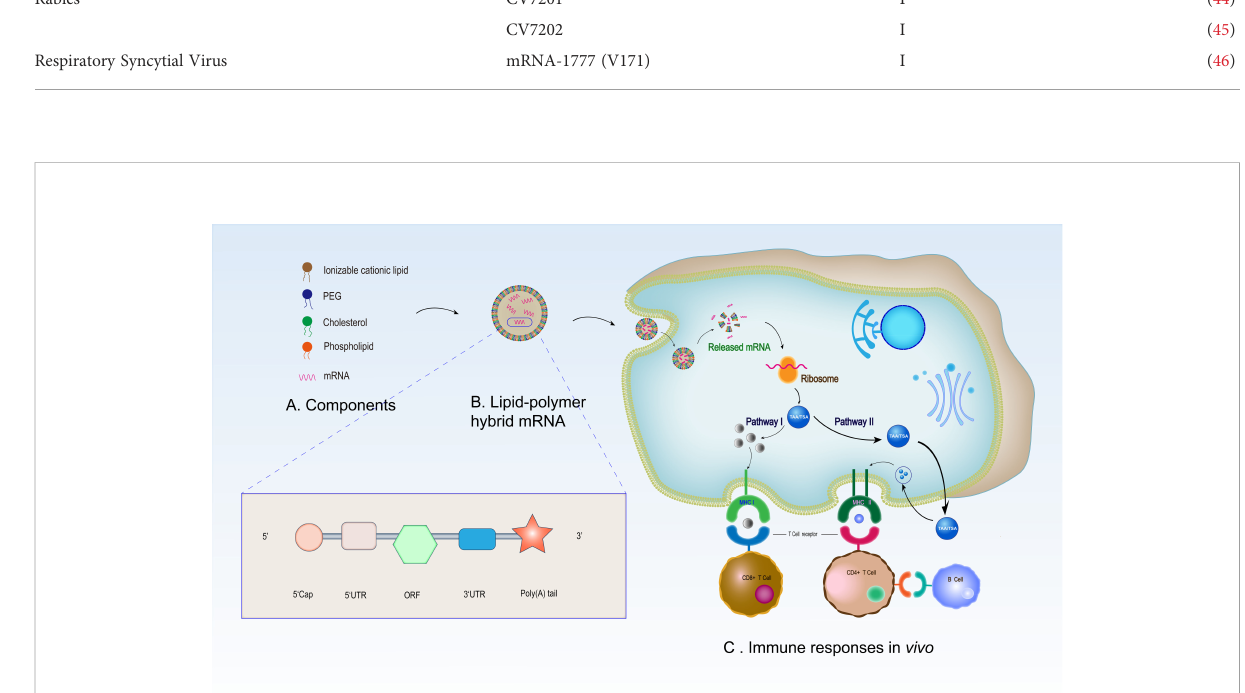
FIGURE 2 Synthesis and mechanisms of LNP-based mRNA vaccine in immunotherapy. (A) Synthetic raw materials of LNP -based mRNA vaccine. (B) Morphology of the assembled mRNA. The mRNA structure in the liposome is composed of a 5 ’ cap structure, 5 ’ - and 3 ’ - UTR, a 3 ’ poly (A) tail and an open reading frame. (C) Immune responses of LNP-based mRNA vaccine in vivo . After entering the human body, the LNP-based mRNA vaccine enters antigen-presenting cells through endocytosis before releasing the mRNA in the cells. The released mRNA translates the target antigen in the ribosome. Subsequently, endogenous antigens are degraded into polypeptides and are presented by MHC I and activate CD8+ T cells (pathway I). In addition, secreted antigens can be taken up by cells, degraded inside endosomes, and presented on the cell surface to CD4+ T cells by MHC II. Finally, CD4+ T cells stimulate B cells to promote B cell maturation and then B cells produce speci fi c antibodies to play an anti-tumor role (pathway